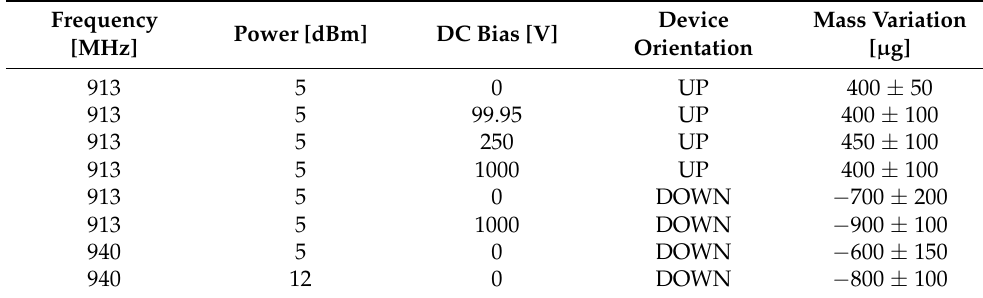
Figure 7. The device on the plate of the balance machine (general view ( a ); enlarged view ( b )). The orientation is the one referred to in Table 1 as DOWN. The black coaxial cable carries the RF signal. The red cable is connected to the high-voltage generator. Table 1. Absolute mass change (positive = gain, negative = loss) as a function of the electromagnetic fields submitted to the device. The RF frequency is expressed in MHz, the power in dBm, the DC bias in volts and the mass and their standard deviations in µ g . The label UP says that the device is oriented as in Figure 2, whereas DOWN indicates the opposite orientation. We recall that the device has a mass of approximately 370